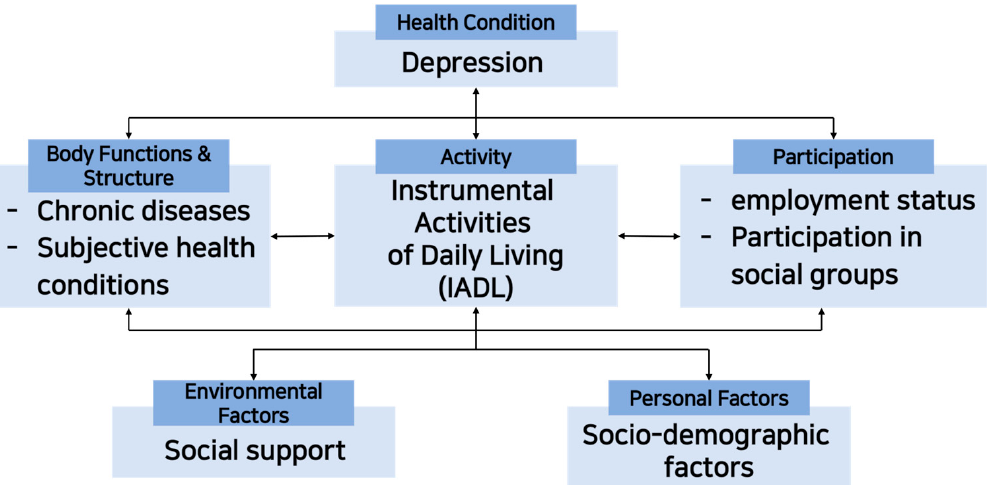
Figure 1. Composition and variables of the International Classification of Functioning, Disability, and Health.